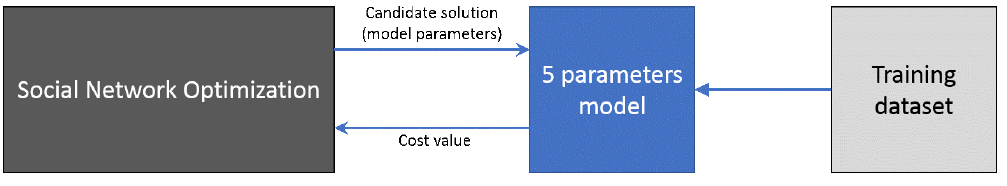
Figure 3. Diagram of the optimization process: interaction between the optimizer and the physical model.